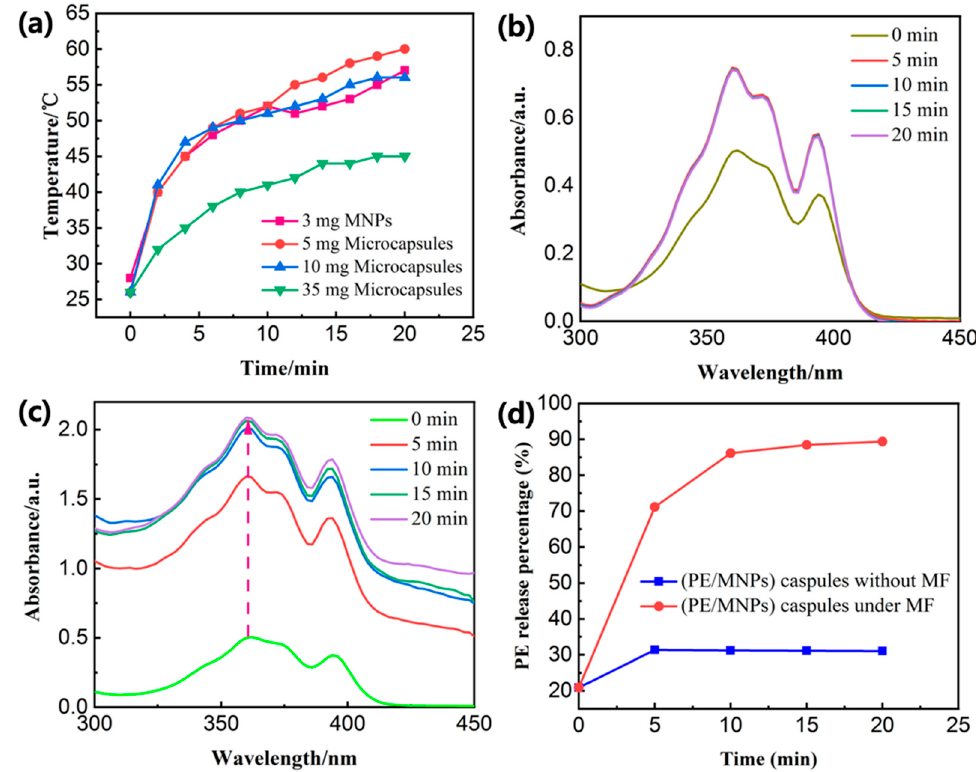
Figure 6. ( a ) Inductive heating ability of the different weights of the PE-loaded magnetic nanoparticles microcapsules (PE/MNPs microcapsules) under high-frequency magnetic field (HFMF) exposure (16.5 kW). ( b ) PE molecule release of PE/MNPs microcapsules (5 mg) in 1.5 mL CH 3 CN without HFMF at room temperature monitored by ultraviolet–visible (UV–Vis) spectroscopy. ( c ) PE molecule release profile of PE/MNPs microcapsules in 1.5 mL CH 3 CN under 20 min HFMF exposure (16.5 kW). ( d ) PE molecule release behaviors of PE/MNPs microcapsules under HFMF and room temperature for 20 min.